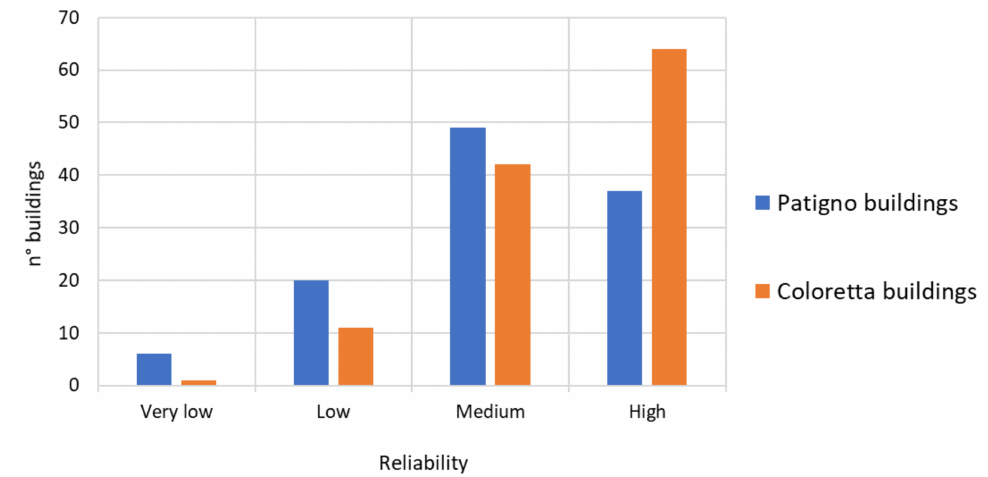
Figure 9. Building classification of both Patigno (in blue) and Coloretta (in orange) hamlets of the reliability between damage and Vslope